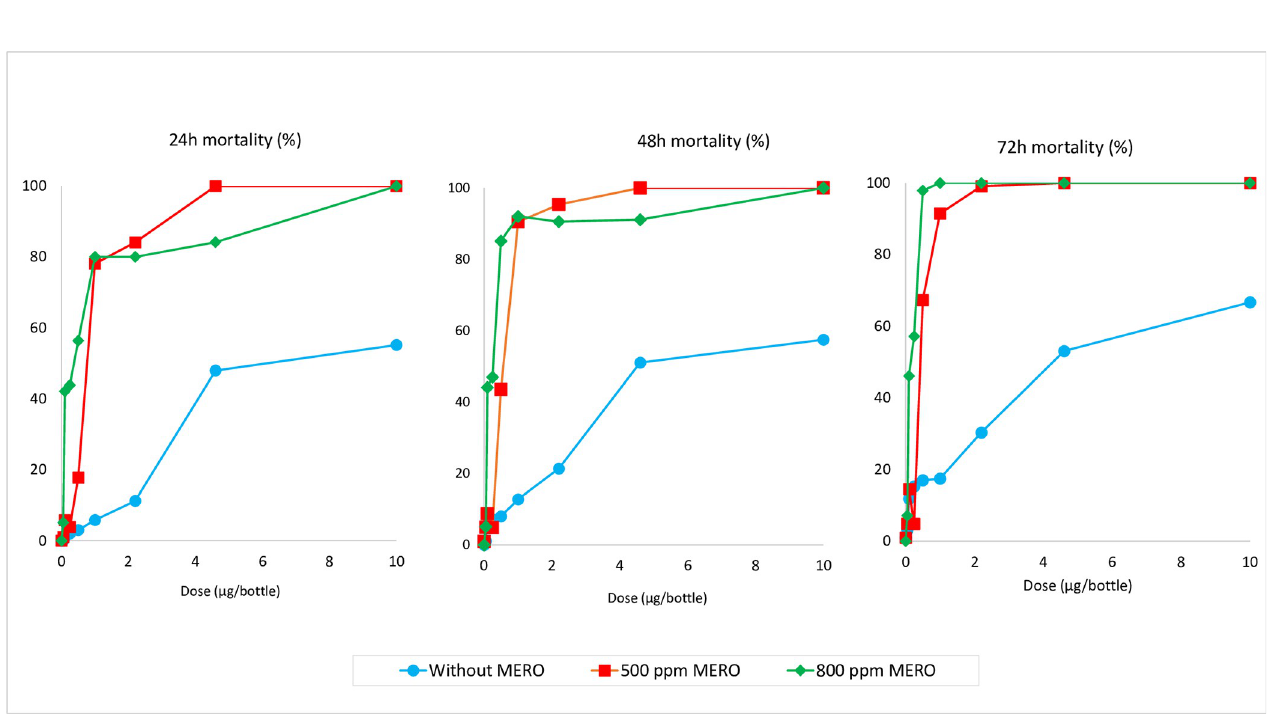
Fig 2. Dose response mortality results with susceptible An . gambiae s.s. Kisumu at a) 24h b) 48h and c) 72h post exposure to broflanilide treated bottles with varying doses of Mero 1 adjuvant.